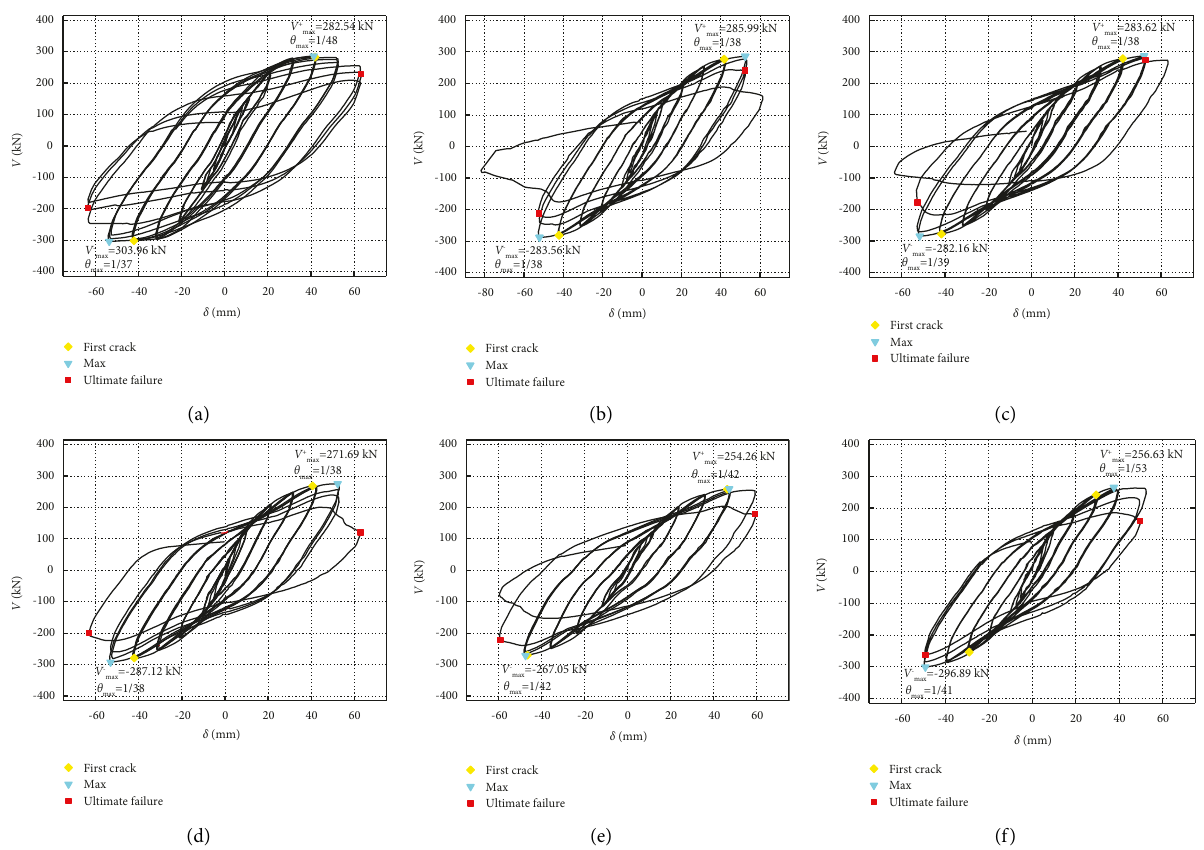
Figure 13: Load-displacement curves. (a) Specimen I-0 ( n � 0.2). (b) Specimen II-1 ( n � 0.2, t